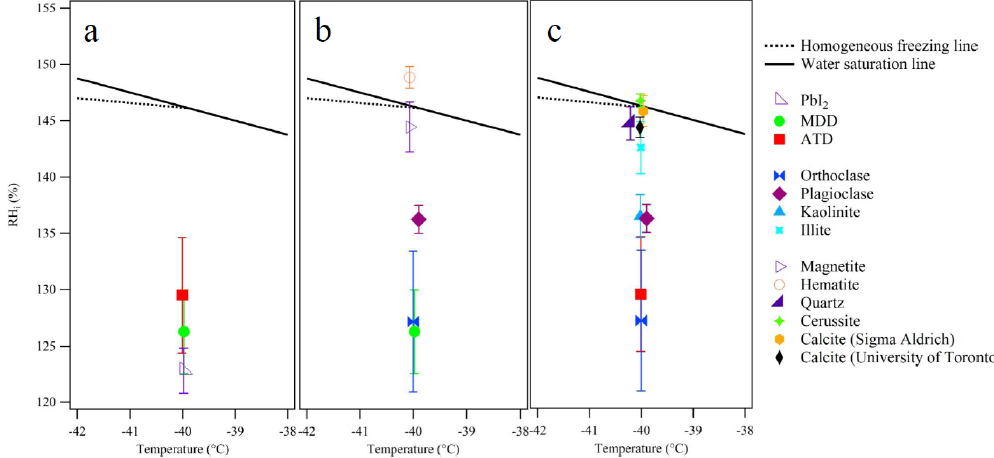
Fig. 3. Critical RH i at which 0.1% of particles were activated at a temperature of − 40.0 ± 0.3 ◦ C. The solid black line represents the water saturation line and the dotted black line represents the homogeneous freezing line (Koop et al., 2000; Murphy and Koop, 2005). The three panels are as follows: (a) ATD, MDD, and PbI 2 ; (b) MDD and its mineral components (orthoclase, plagioclase, magnetite, hematite); (c) ATD and its mineral components (orthoclase, plagioclase, kaolinite, illite, quartz, and carbonates such as calcite and cerussite). The error bars represent the standard deviation of the critical RH i measured in individual experiments, of which each point is the average of at least three scans.